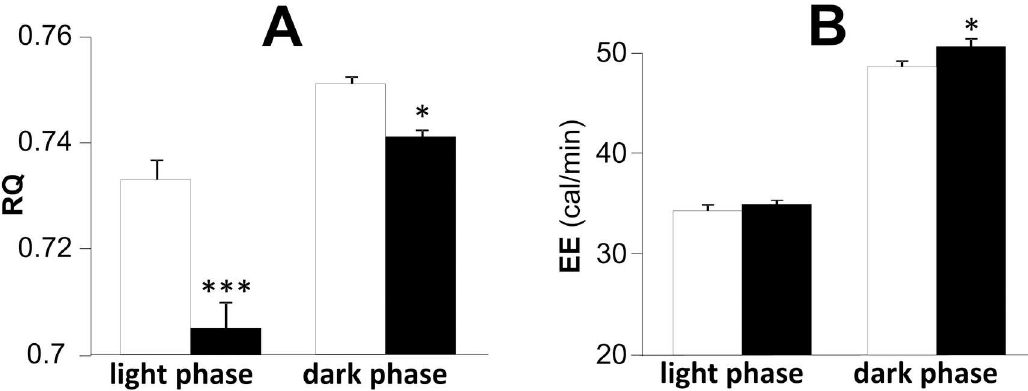
Fig 4. Effects of metformin on respiratoryquotient (RQ, A) and energy expenditure (EE, B) in SD rats at 15 weeks old. Open bars denote control group and black bars denotemetformin-treated group. Data are presentedas mean ± S.E. (n = 10 in each group). * P < 0.05, *** p < 0.001vs. control